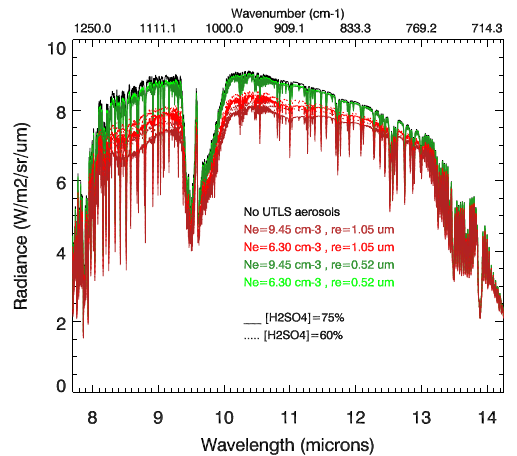
Figure 10. Simulated radiances for baseline no UTLS aerosol con- ditions (black) and different UTLS aerosols with different H 2 SO 4 mixing ratios, effective radii and effective number concentrations (light and dark green and red; please see legend for details). The abscissa is expressed in both wavelength (to more readily compare with Fig. 1 of Corradini et al., 2009) and